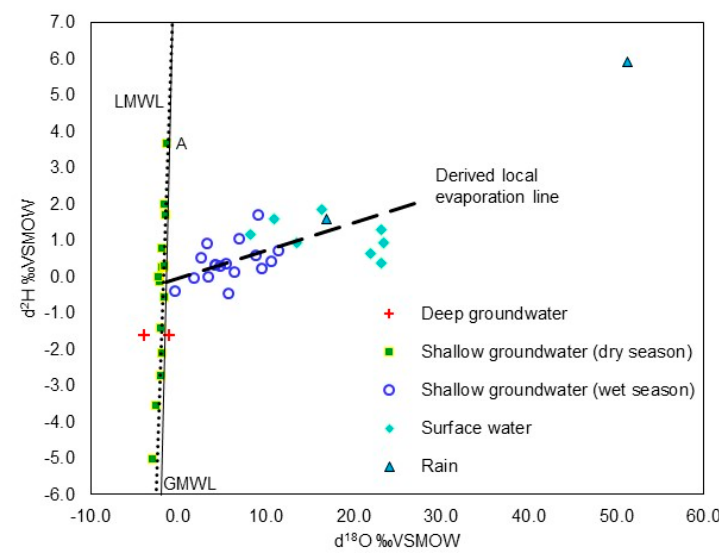
Figure 6. Stable isotope measurements by water source and season. Global Meteoric Water Line (GMWL) is shown as a solid line and Addis Ababa Local Meteoric Water Line (LMWL) is indicated as a dotted line [63]. Sample A is referred to in the text.